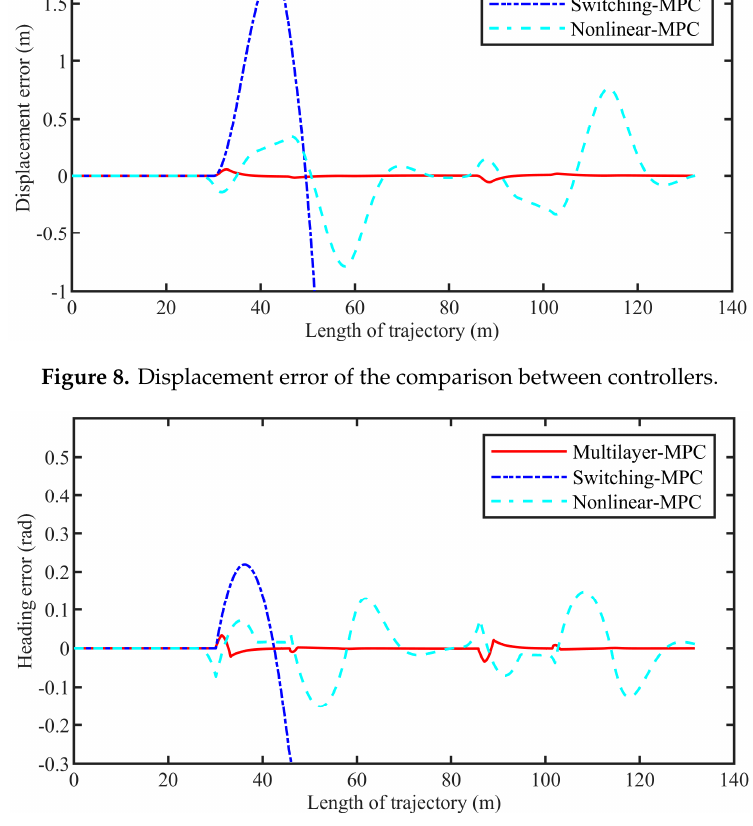
Figure 9. Heading error of the comparison between controllers.